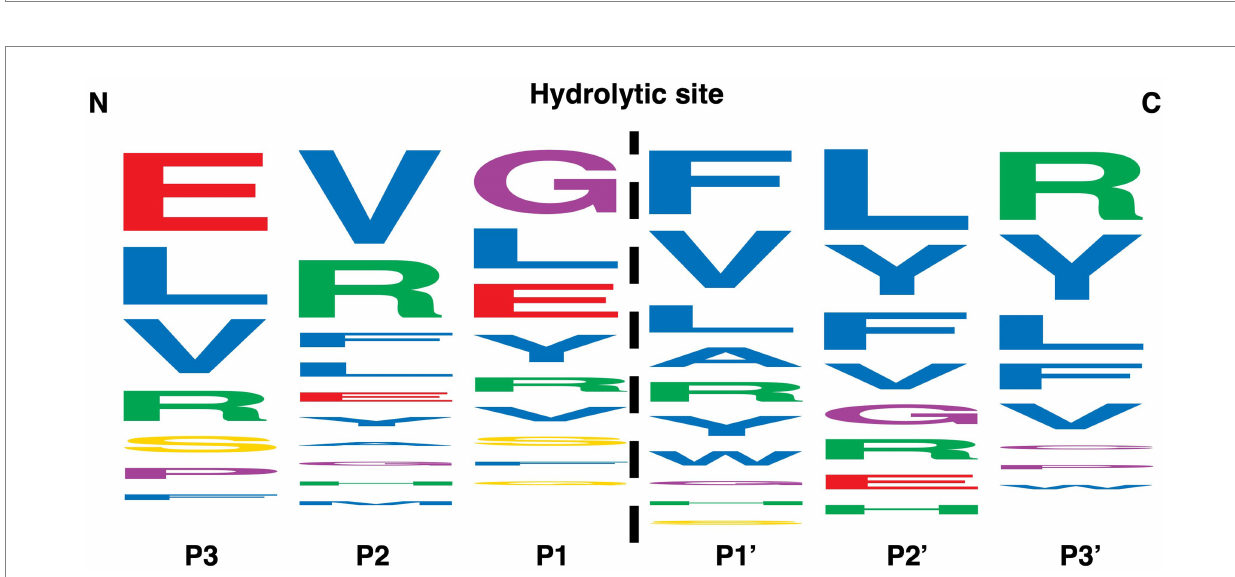
FIGURE 6 Amino acid specificity analyzed by LC-MS/MS. The position and size of each letter is based on the frequency of a particular amino acid +/ − three positions from the MdpL hydrolytic site (dashed line). The larger the size in a particular position, the more frequent the amino acid appears after digestion of Neuromedin-U25, MOG, and Insulin Chain B Oxidized, which was based on the 89 identified peptides from the hydrolyses. Amino acids are given a color based on the side chain; Red – negative charge, Green – positive charge, Yellow – uncharged, Purple – special, Blue –